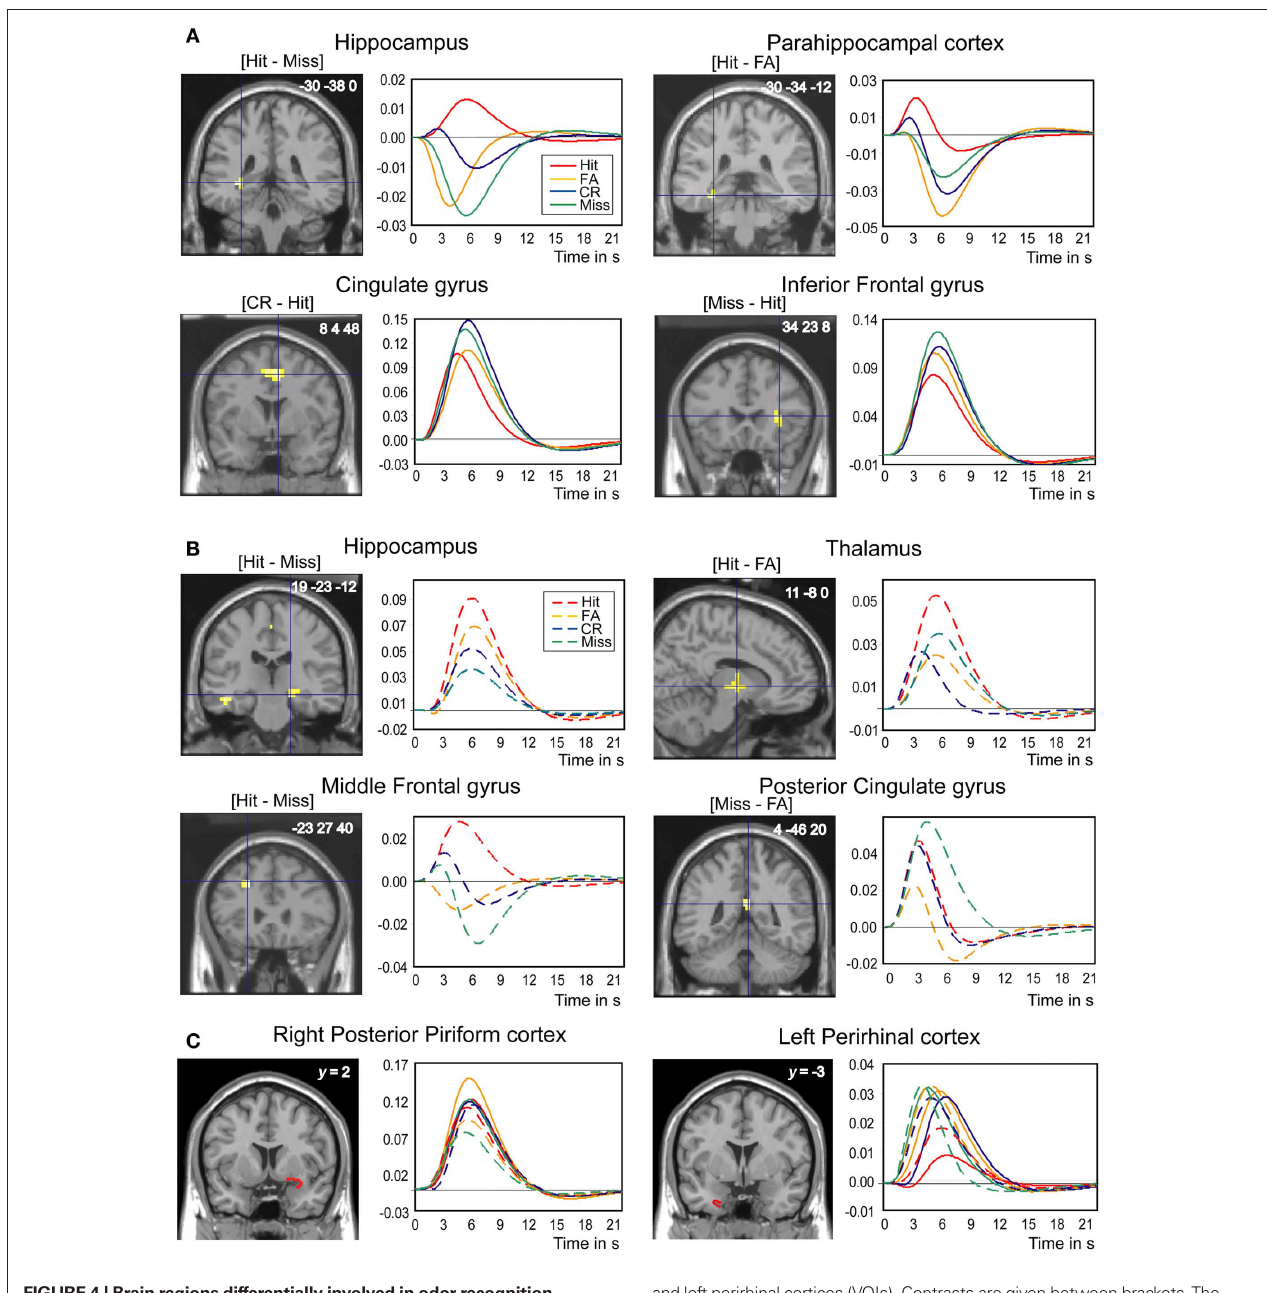
FIguRe 4 | Brain regions differentially involved in odor recognition memory as a function of the four response categories (Hit, Miss, CR, and FA). (A) In young subjects, the hippocampus, the parahippocampal gyrus, the cingulate gyrus, and the inferior frontal gyrus. (B) In elderly subjects, the hippocampus, the thalamus, the middle frontal gyrus, and the posterior cingulate gyrus. (C) In young and elderly subjects, the right posterior piriform